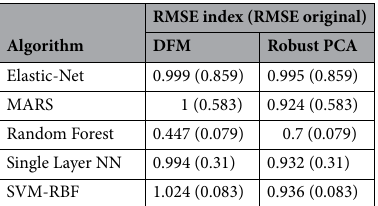
Table 4. RMSE in predicting Unemployment rate using continuous index as regressor. RMSE for regression with original variables is reported in parenthesis.